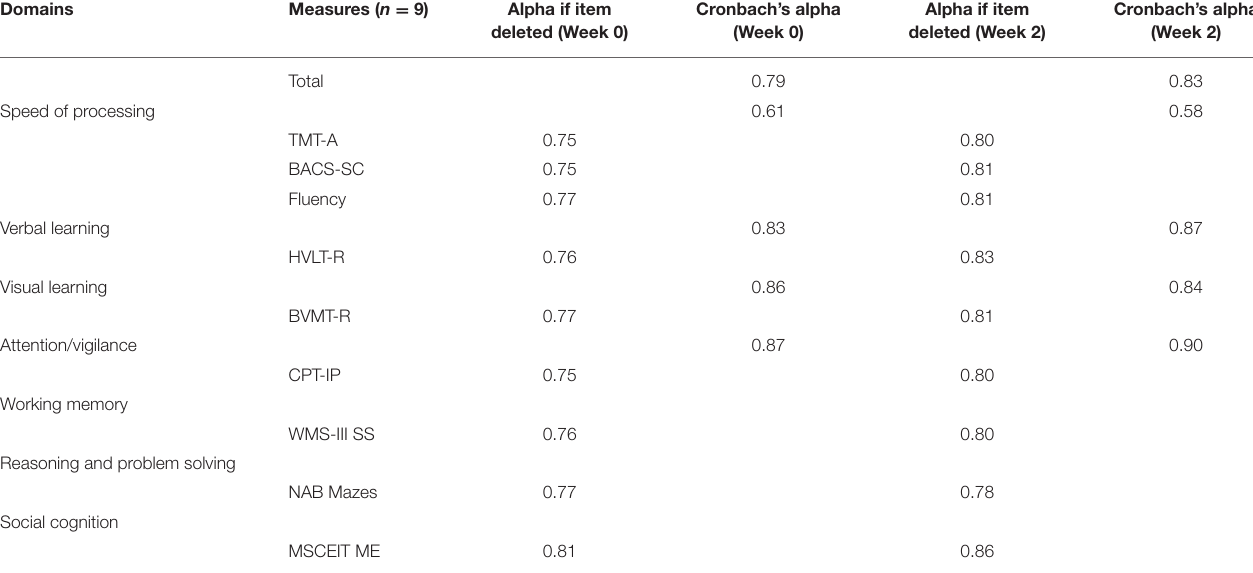
TABLE 2 | The internal consistency reliability in Y-MDD